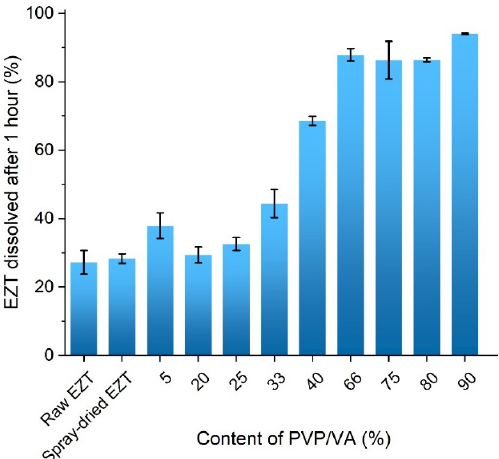
Figure 8. Dissolution of EZT from solid dispersions containing different amount of PVP/VA after one hour. one